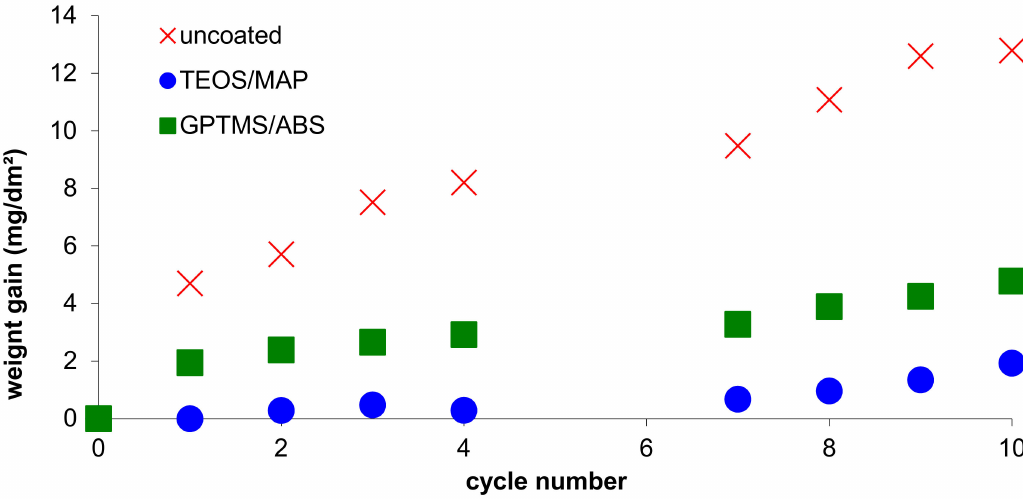
Figure 5. Weight gain during climatic chamber test.